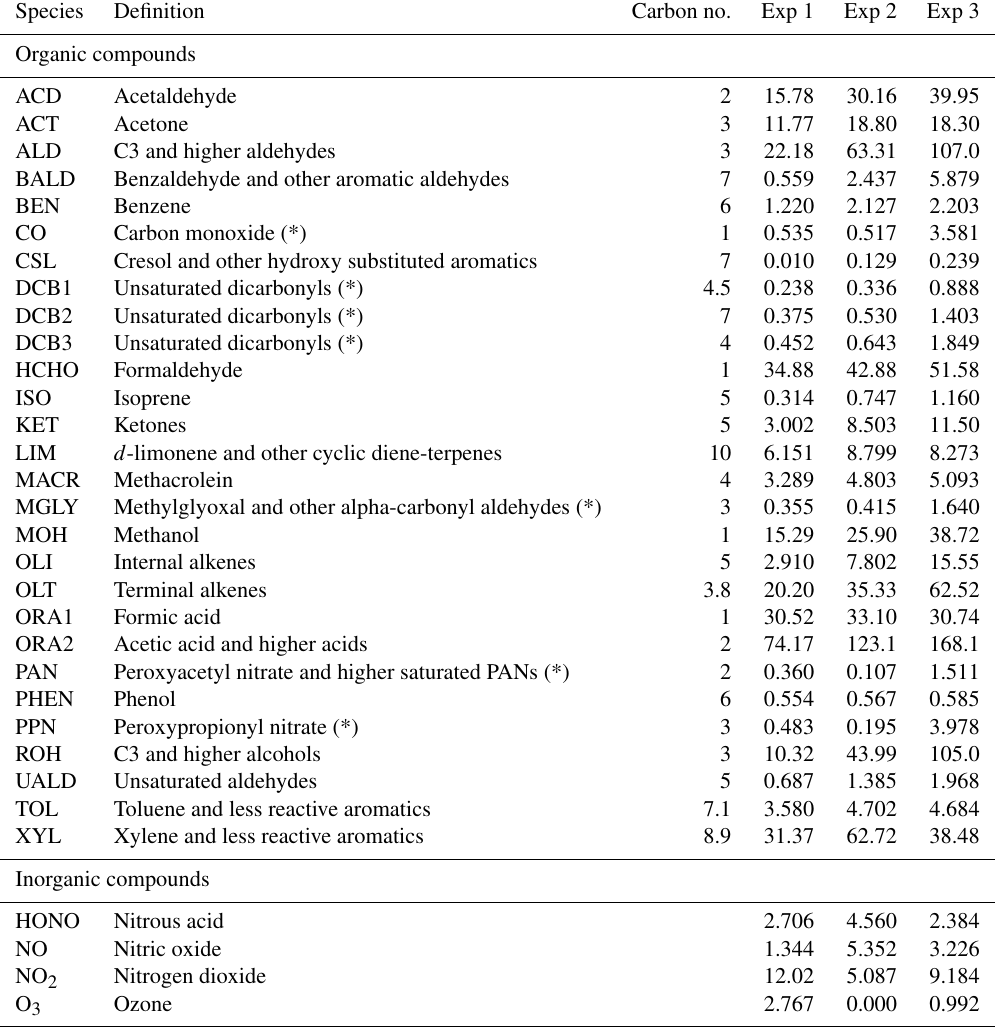
Table 4. List of the RACM2 compounds initialized. The table shows the definition, carbon valence and concentrations at the start of the experiments; concentrations are in micrograms per cubic metre (µgm − 3 ). Compounds marked with a symbol (*) were not measured experi- mentally, but were estimated based on simulations to assess their importance regarding initial conditions (see Sect.